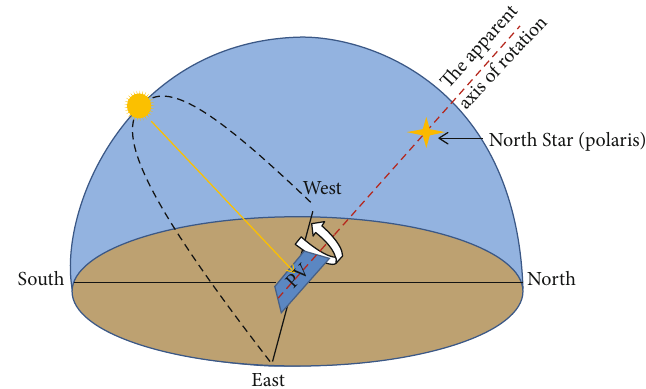
Figure 8: The solar tracker on an equatorial mount.